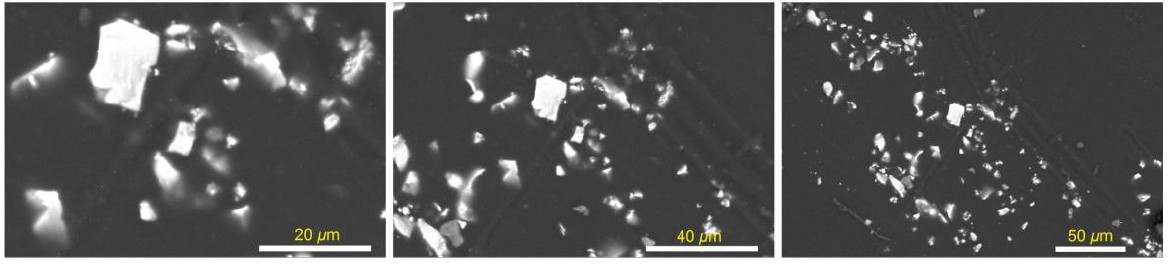
Figure 4. SEM images of PCP-0.5 at various enlargements.